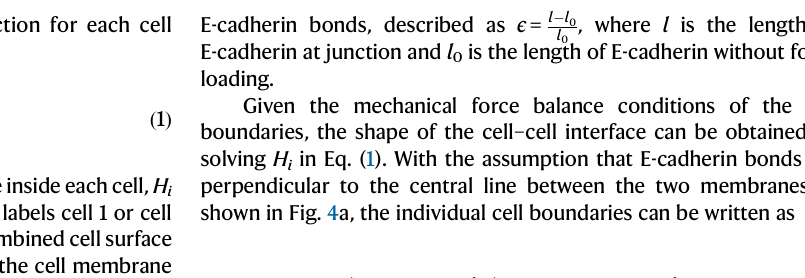
with SICM and plotted to determine their correlation: individual cells were mea- sured on circles ( N =36; squares N =39 – 42; triangles N =48). Goodness of fi t ( R 2 ) values are shown for each comparison and geometric shape. Different micro- patterngeometries are representedatthe bottom or insidegraphsasred (circles), green (squares) and orange (triangles) lines or shapes. Scan sizes shown in ( a ) are: circles40 μ m×40 μ m,squares46 μ m×46 μ mandtriangles53 μ m×53 μ m.Graphs represent average values between neighbouring cells sharing a micropattern and error bars are SEM ( N =3 ( a , b ); N =7 ( c – h ). Statistical analysis was performed by one-way ANOVA followed by Kruskal – Wallis post-hoc test and Benjamin, Krieger and Yekutieli test. Source data are provided as a Source Data fi le. p values in black font are comparisons across shapes; p values in coloured font represent compar- isons within a geometric